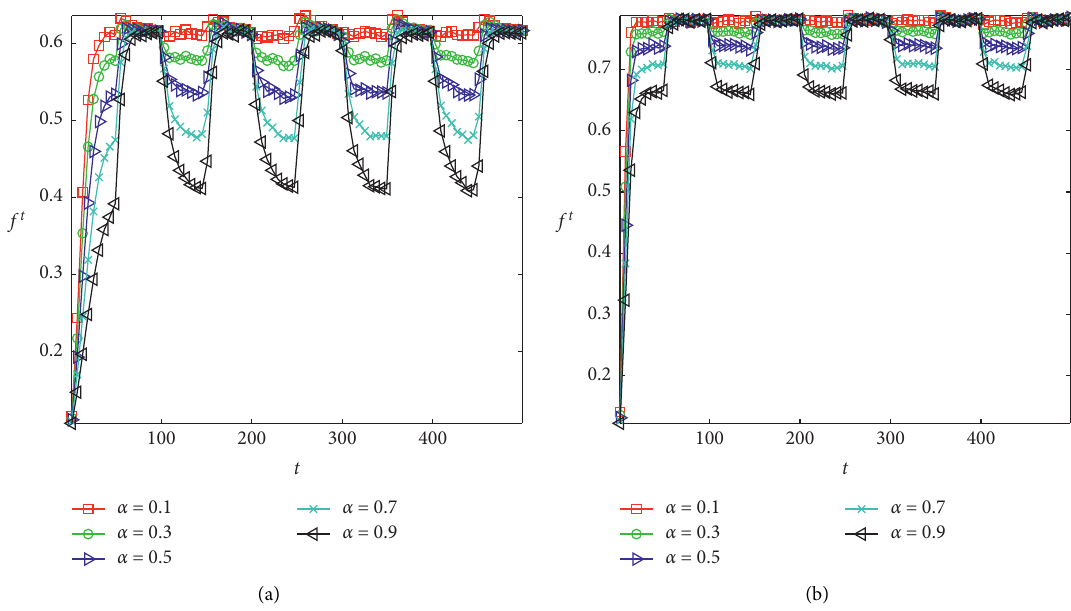
Figure 7: The infected density f t evolves with time under different regional heterogeneous infection coefficient α . It is interesting to find that the fluctuation period of the infected density f t is almost the same under different α . The parameters are set to be t s � 50, p � 0 . 5, � 0 . 001; (b) the infection rate λ � 0 . β � 0 . 1. (a) The infection rate α 0 0